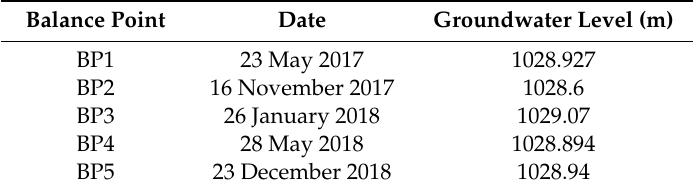
Table 4. Balance points of groundwater level between sand dune and wasteland in di ff erent periods.